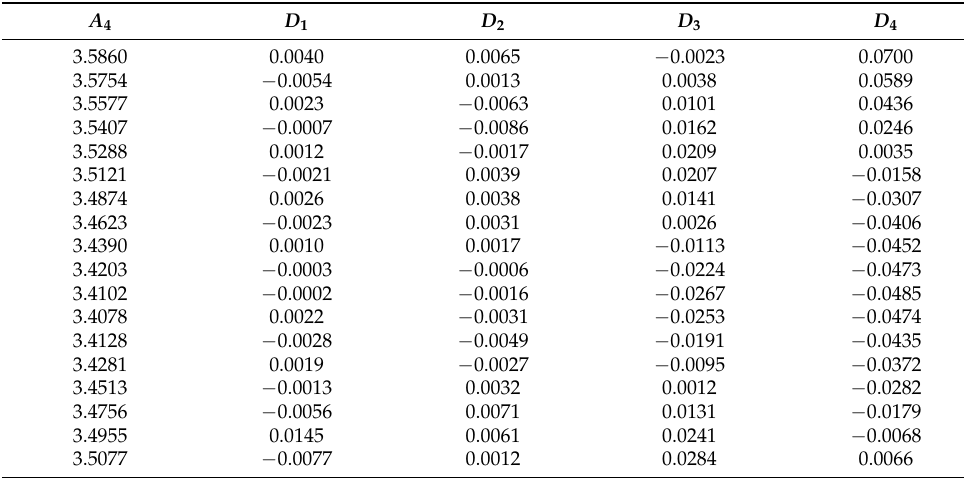
Table 7. Four-level wavelet decomposition of V 6 .